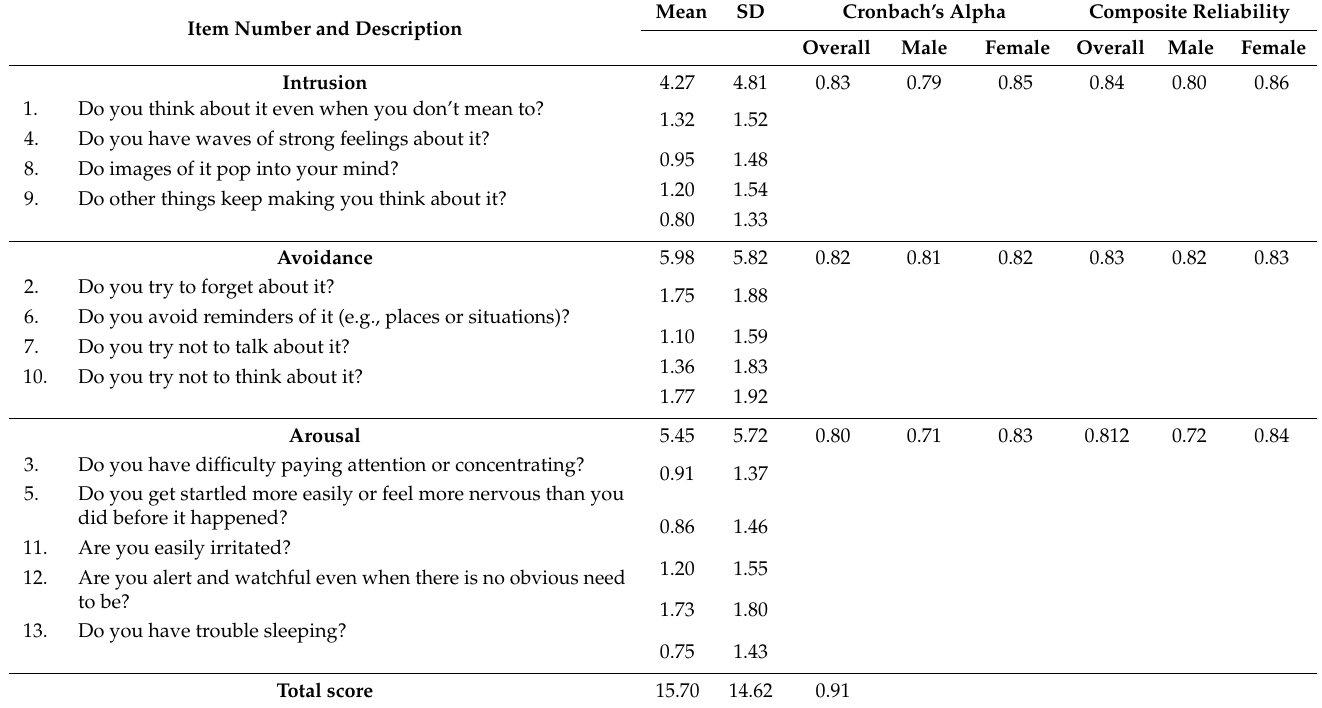
Table 3. Scale description and internal consistency reliability of